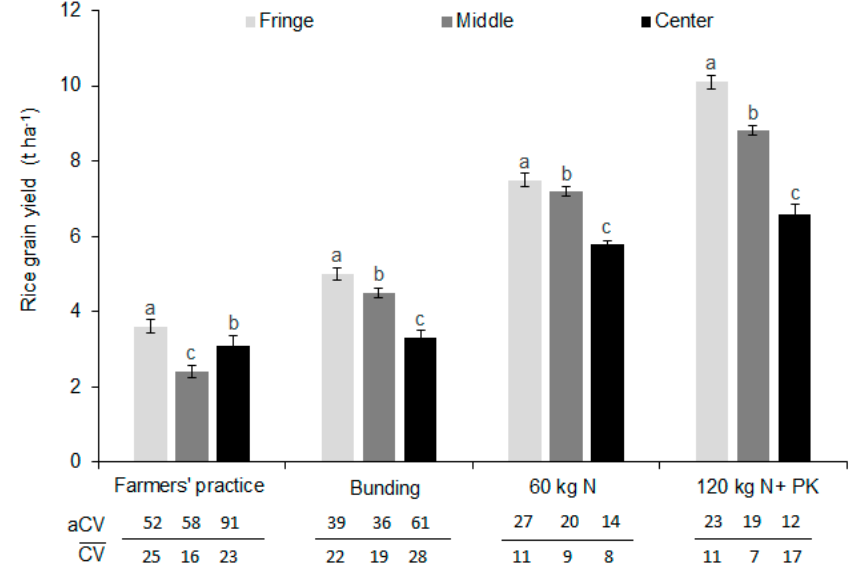
Figure4. E ff ectofmanagementpracticesonthegrainyield(tha − 1 86%dm)oflowlandrice, di ff erentiated Figure 4. Effect of management practices on the grain yield (t ha − 1 86% dm) of lowland rice, by hydrological positions and their associated percentage adjusted coe ffi cients of variation across differentiated by hydrological positions and their associated percentage adjusted coefficients of years and replicates (aCV presented below the graph), and mean unadjusted coe ffi cients of variations variation across years and replicates (aCV presented below the graph), and mean unadjusted across years ( CV ) in Kilombero floodplain, Tanzania, 2015–2017. Di ff erent letters indicate significant coefficients of variations across years ( 𝐶𝑉(cid:3364)(cid:3364)(cid:3364)(cid:3364)(cid:4667) in Kilombero floodplain, Tanzania, 2015–2017. Different di ff erences by Tukey test at p ≤ 0.05 between letters indicate significant differences by Tukey test at p ≤ 0.05 between positions.